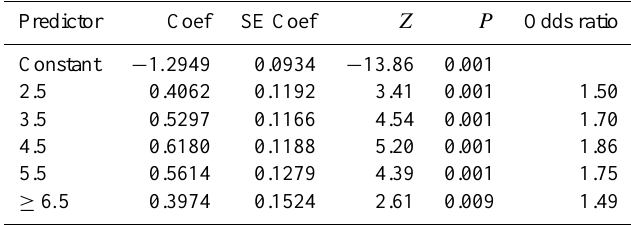
Table 8. Logistic regression model for the influence of ewe premating age on the multiple birth rates. ∗ Predictor Coef SE Coef Z P Odds ratio Constant − 1 . 2949 0.0934 − 13 . 86 0.001